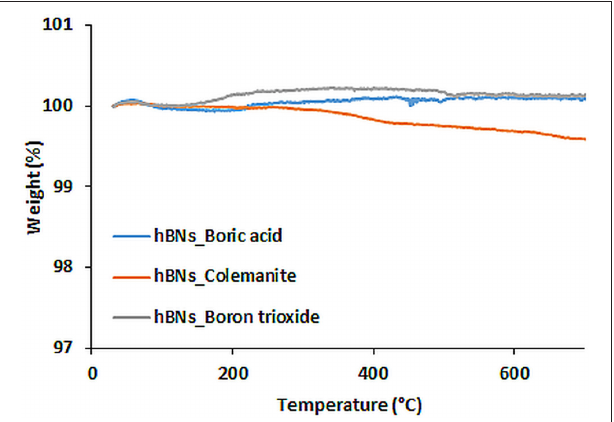
FIGURE 4 | TGA curves of hBNs synthesized from different precursors.